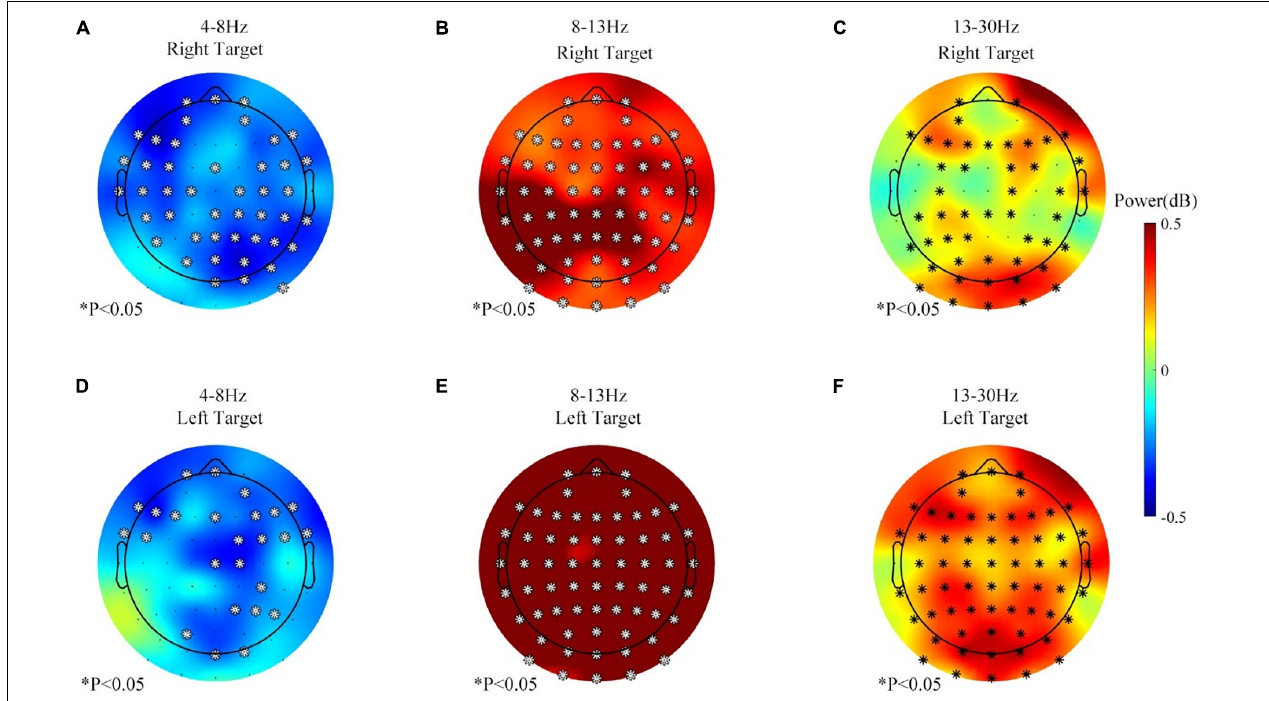
FIGURE 6 | The band power changes during the no-rest session, 201–400 vs. 1–200 trials, feedback period. (A) Theta (4–8 Hz) power change of the right target. (B) Alpha (8–13 Hz) power change of the right target. (C) Beta (13–30 Hz) power change of the right target. (D) Theta (4–8 Hz) power change of the left target. (E) Alpha (8–13 Hz) power change of the left target. (F) Beta (13–30 Hz) power change of the left target. ∗ p ≤